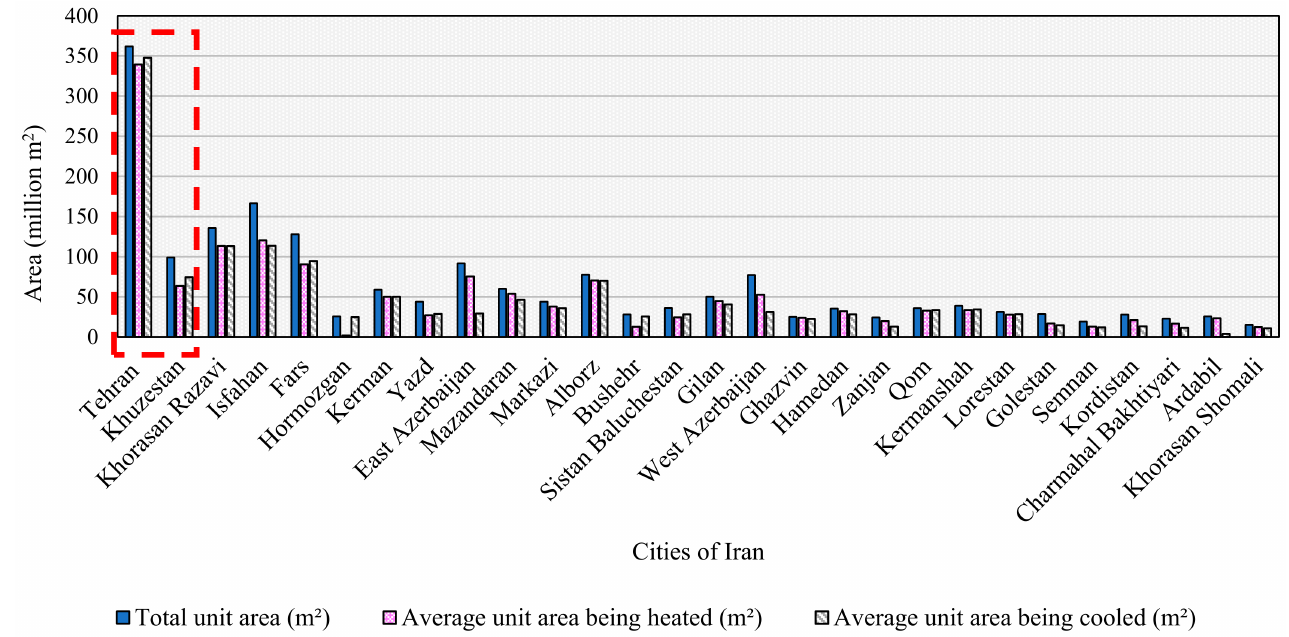
Figure 24. The average area of domestic units being heated or cooled in provinces of Iran in